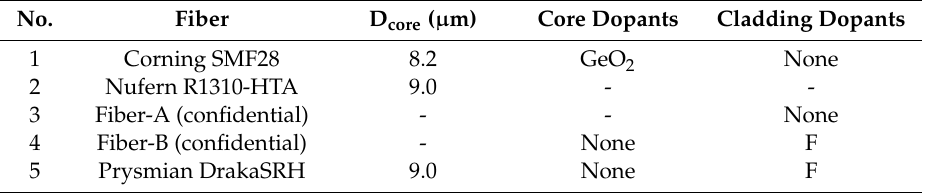
Table 2. Optical fibers for the fabrication of arc-induced LPGs. Data provided by manufacturers.